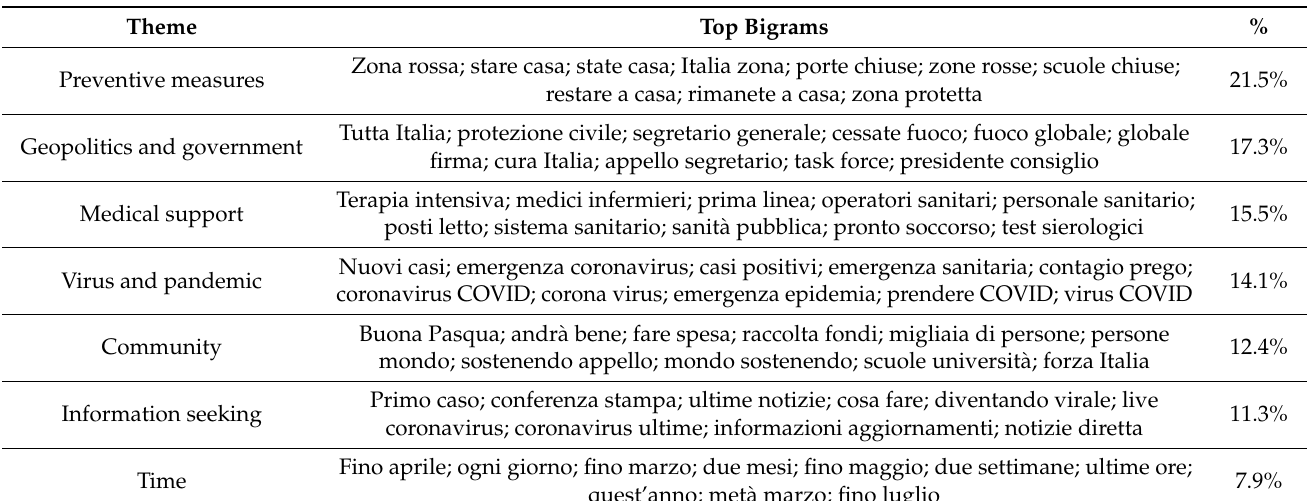
Table 1. Results from the semantic analysis, theme identified, top bigrams associated and overall frequency of mentions throughout the study